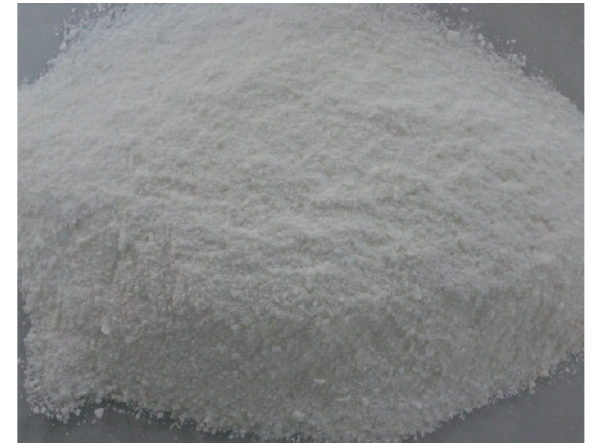
Figure 4: Bone product from cod backbones after processing and